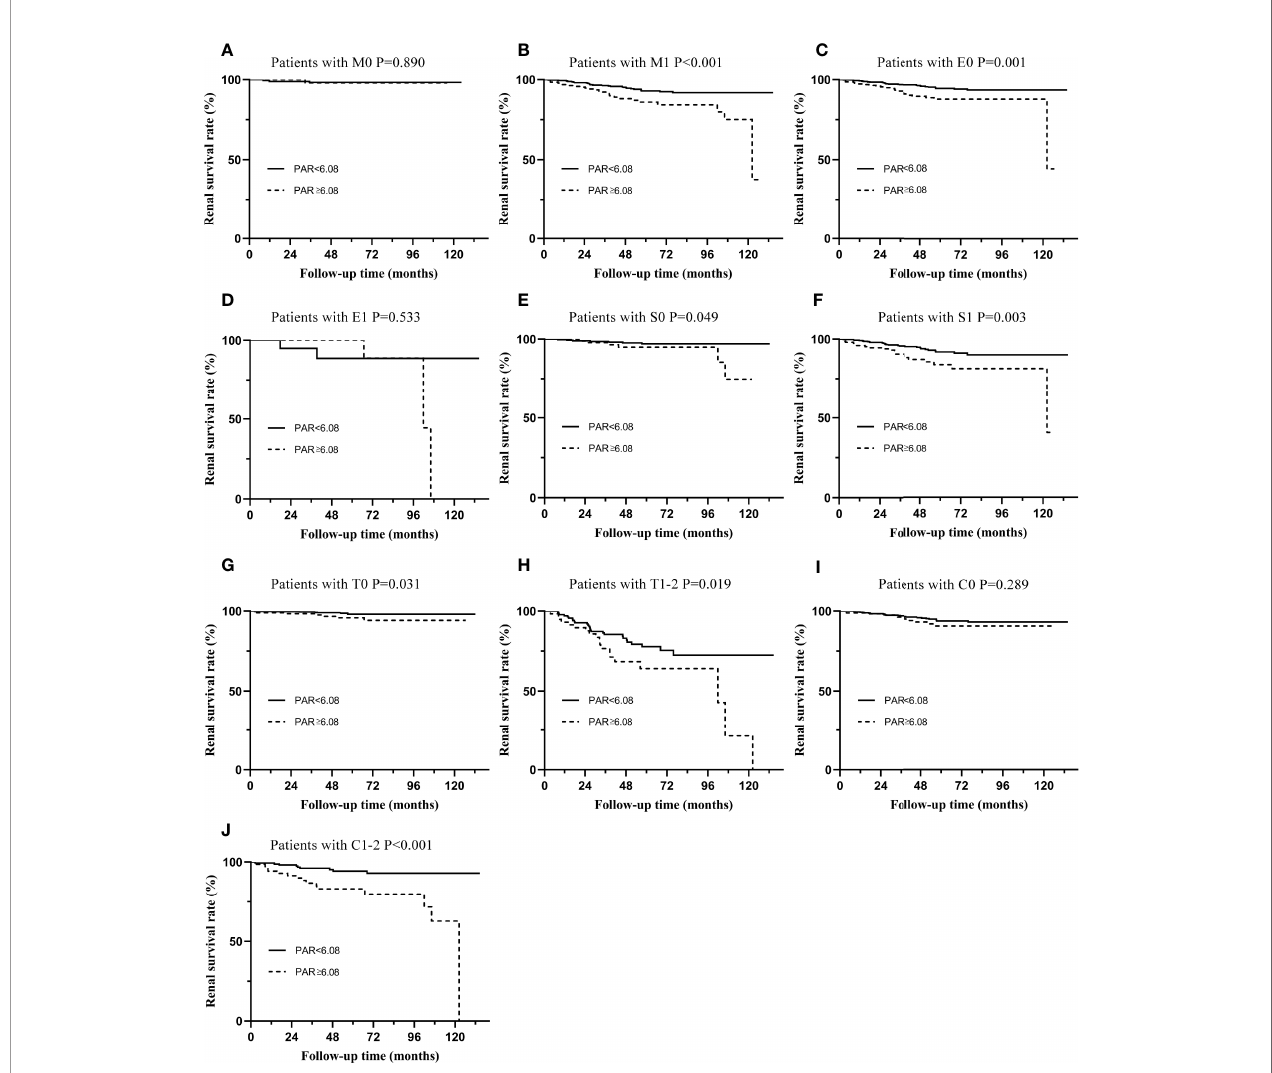
FIGURE 4 | Subgroup analysis of IgAN patients with different types of pathological lesions. The Kaplan-Meier curve of patients with M0 (A) , M1 (B) , E0 (C) , E1 (D) , S0 (E) , S1 (F) , T0 (G) , T1-2 (H) , C0 (I) , C1-2 (J) in two groups distinguished by